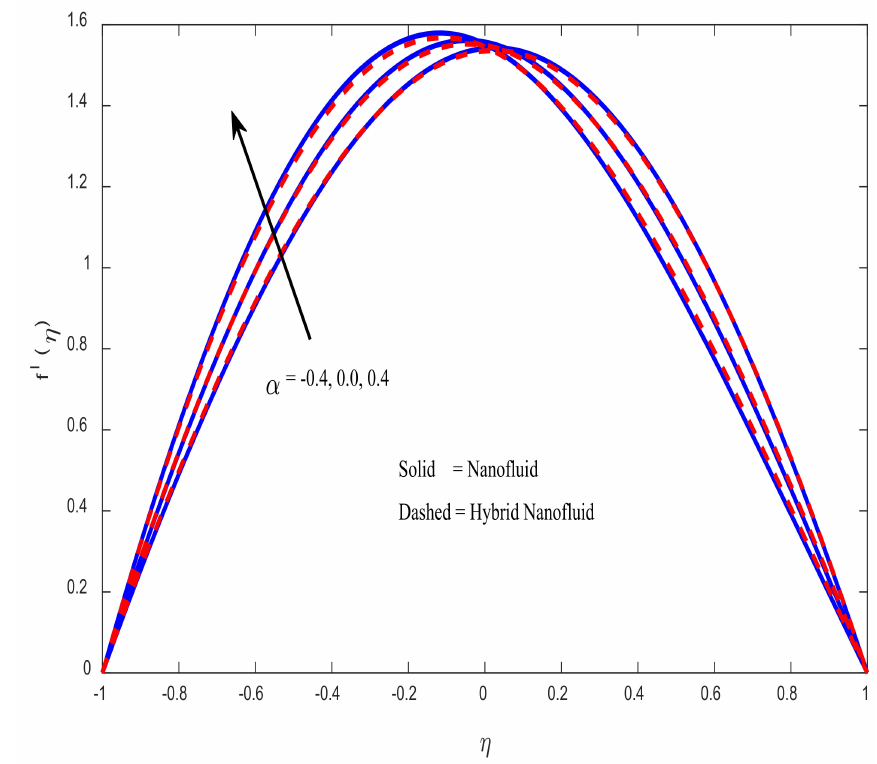
Figure 5. Influence of α on the velocity profile.